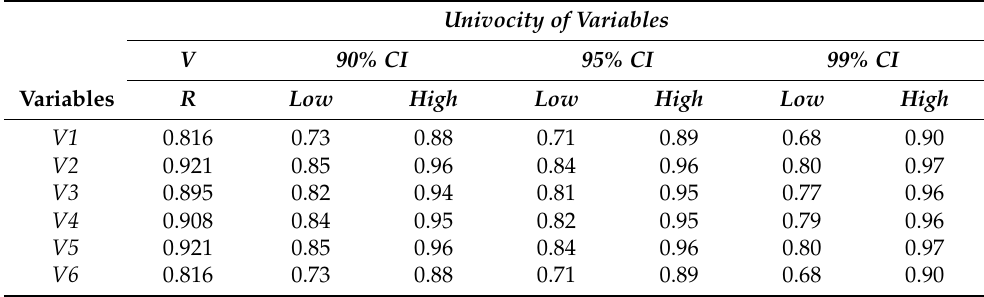
Table 5. Aiken’s V coefficient values and confidence intervals for each of the variable results. Univocity of Variables